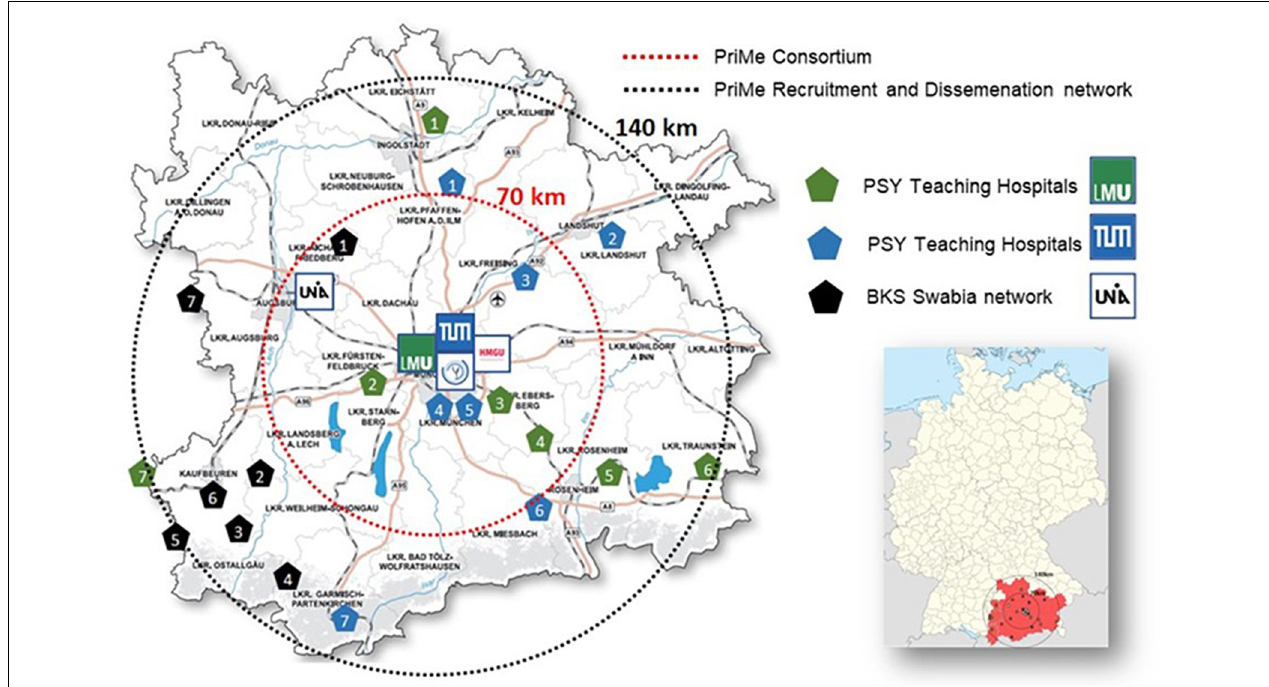
FIGURE 1 | Map of the PRiME’s catchment area. PSY Teaching Hospitals LMU: 1. Klinikum Ingolstadt, 2. Hospital Fürstenfeldbruck, 3. Hospital München Ost, 4. Hospital Wasserburg, 5. Hospital Rosenheim, 6. Day Clinic Freilassing, 7. Hospital Memmingen. PSY Teaching Hospitals TUM: 1. Hospital Pfaffenhofen, 2.